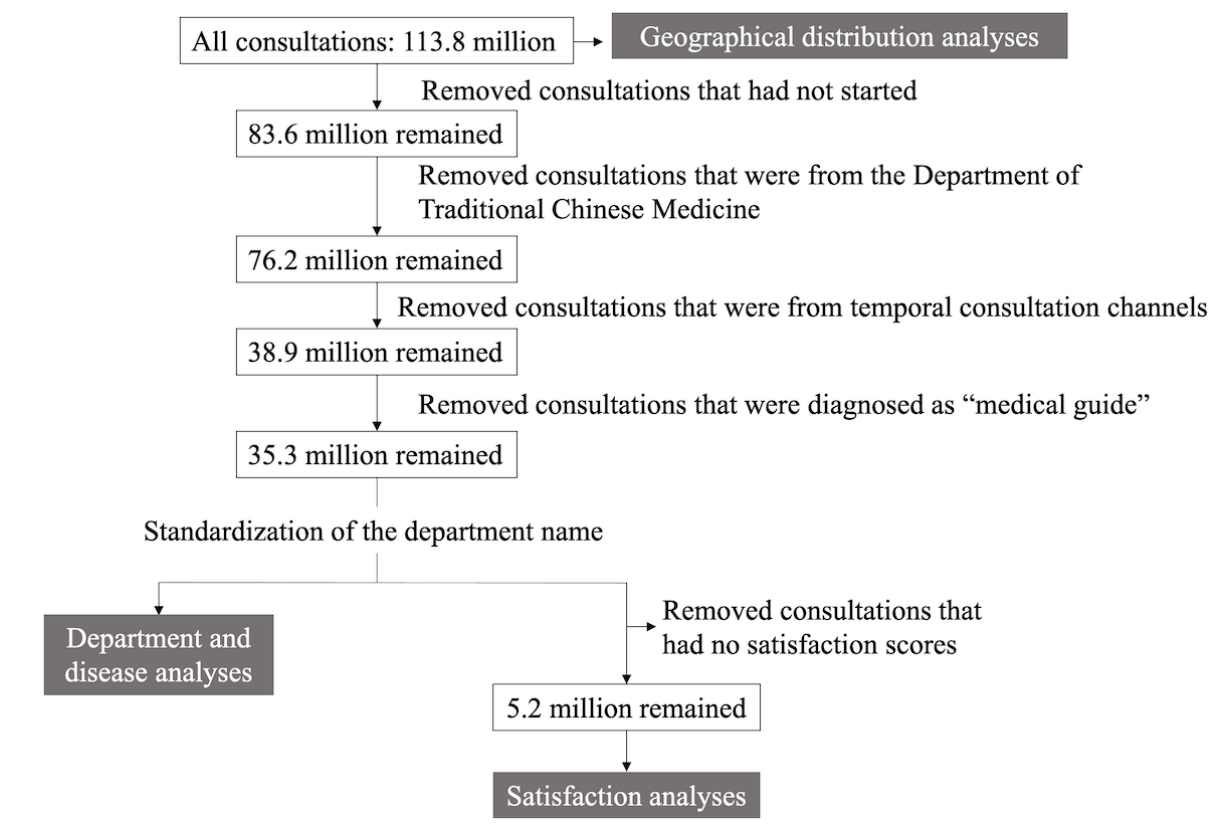
Figure 1. The process of data selection and the data sets that were used for different